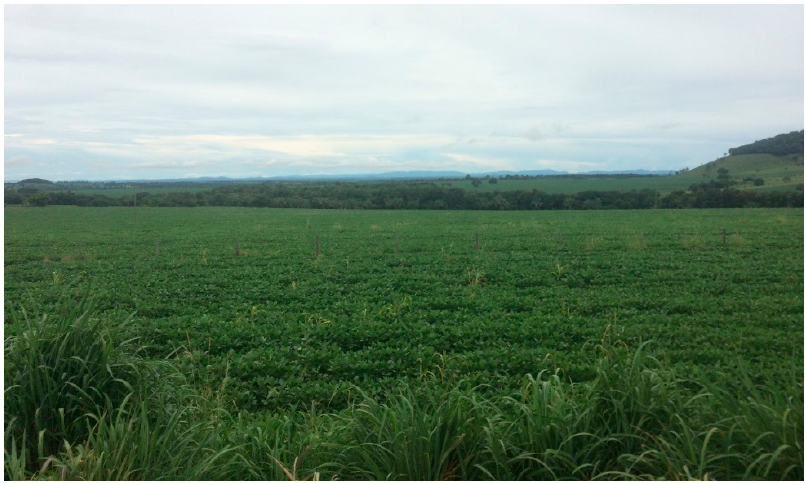
Figure 10. Soybean plantation along BR-153 in January 2021. Prepared by the authors. Greenhouse gases (GHGs) total emissions reached 1.14 gigatons of CO2eq in the Brazilian Amazon in 2019, almost double that of 2010 (i.e., 656.1 megatons of CO2eq). The 455.08 megatons of CO2eq were removed in the region in 2019, as can be seen in Table 11. Pará State was the largest emitter in 2019, with 400.59 megatons CO2eq, followed by Mato Grosso at 230.23 megatons CO2eq, and both states have had great prominence in agribusi- ness. Table 11. GHG emission and removal in the states of the Brazilian Amazon in 2019. Source: [21]. Mt CO2eq States Issue Removal Total Acre 39.62